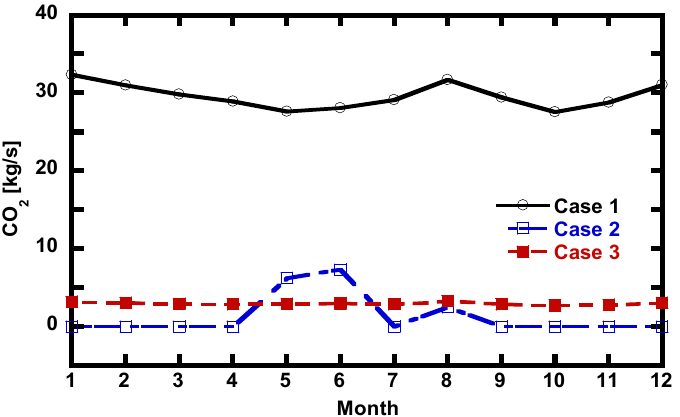
Figure 12. Comparison of annual CO (cid:2870) emissions.